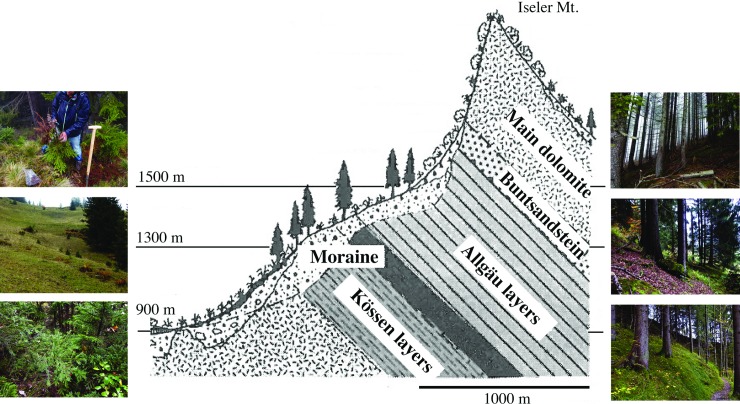
Overview of the study area comprising three sampling sites at three different altitudes along an altitudinal gradient from 900 to 1500 m a.s.l.Collection sites were located at I: 900 m, II: 1200 m and III:1500 m a.s.l in the Bavarian Alps (north side of Iseler Mountain, Germany), modified from Bräker [28]. At each location samples from old and young individuals of Norway spruce were sampled.